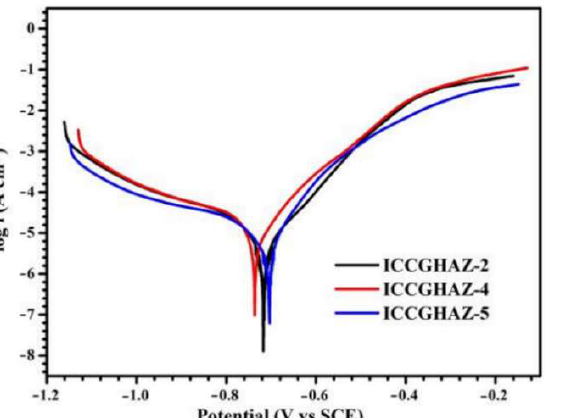
Figure 14. OCP dependent on the immersion time of the ICCGHAZs with different cooling rates in 3.5 wt% NaCl solution.